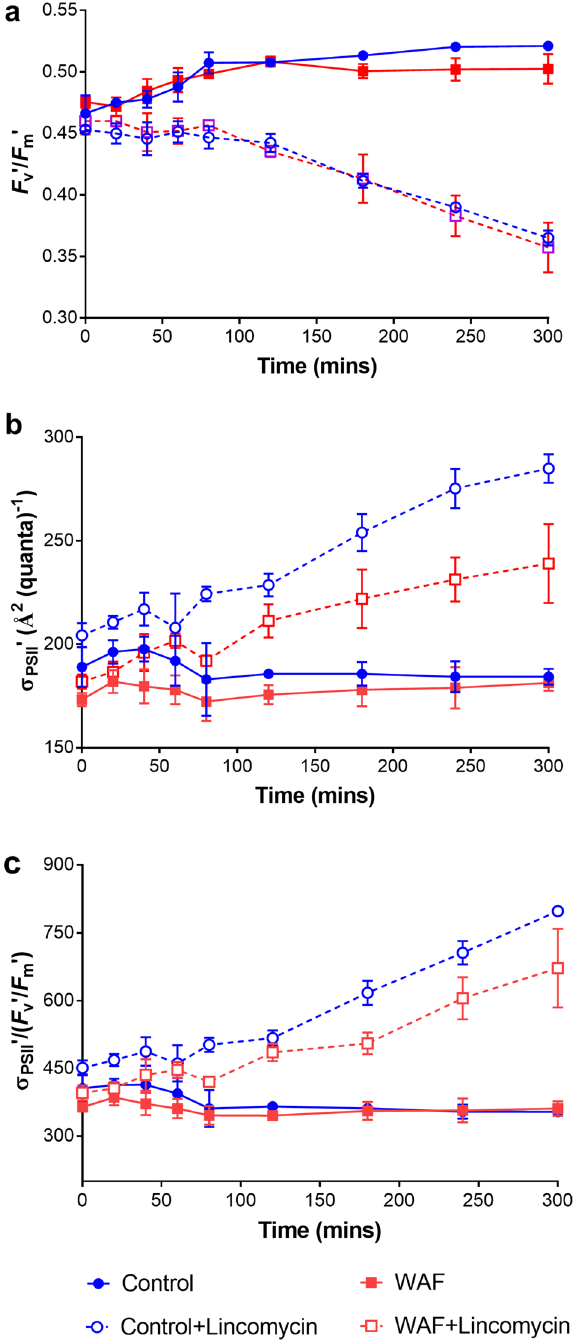
Figure 6. Effect of WAF exposure on the protein components of light harvesting complex. ( a ) average functional cross-section area (σ), ( b ) average quantum yield of PS II ( F v ’/ F m ’), and ( c ) σ/( F v ’/ F m ’) measured in of T. pseudonana cultures after 100 min of in Control and WAF conditions, followed by addition of 2 mM